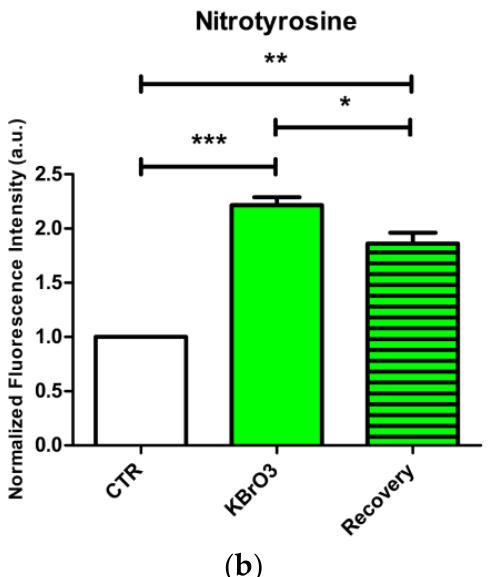
Figure 6. ( a ) Widefield fluorescence displaying DNA (blue) and nitrotyrosine (red) in HeLa cells during experimental conditions. Note the significant signal intensity increment during KBrO 3 treatment. Bars: 10 µ m. ( b ) Histogram representing the normalized fluorescence intensity of nitrotyrosine signal. Asterisks identify statistically significant differences (*: p Value < 0.05; **: p Value < 0.01; ***: p Value < 0.001).